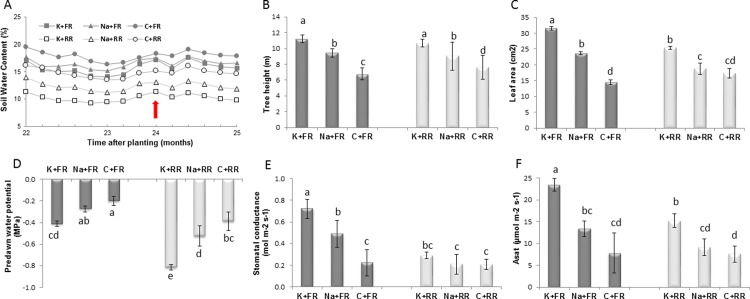
Effect of a 37% reduction in rainfall and K and Na fertilization regimes on soil water content and eucalyptus physiological parameters.Mean soil water content (in the 0.15 to 6 m soil layer), 22 to 25 months after planting. The leaf sampling date, at two years of age, is represented by a red arrow (A). Measurements on two-year-old trees of mean tree height (B), leaf area (C), predawn leaf water potential (D), midday stomatal conductance gs (E) and CO2 assimilation rate (F) measured on two-month-old leaves. Dark gray = full rainfall; Light gray = reduced rainfall.